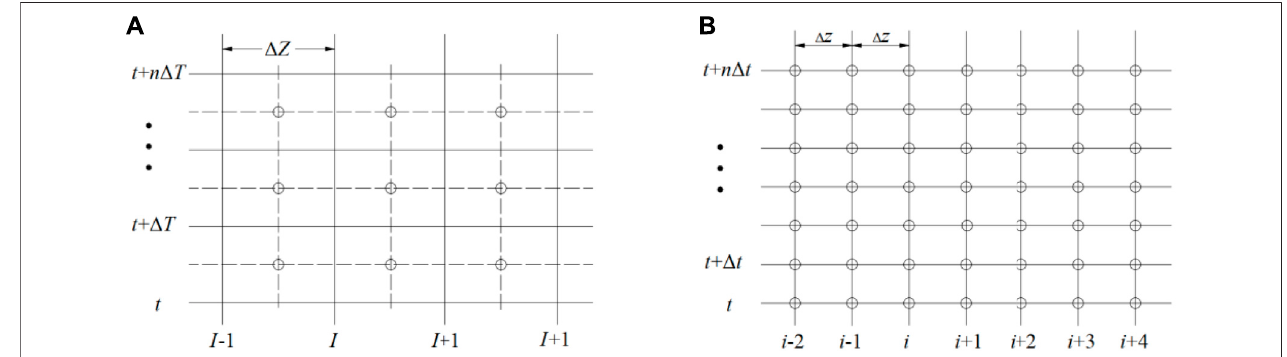
FIGURE 2 | Discretization grids system (A) Cell-centered form of FVM. (B) An equivalent grid system of